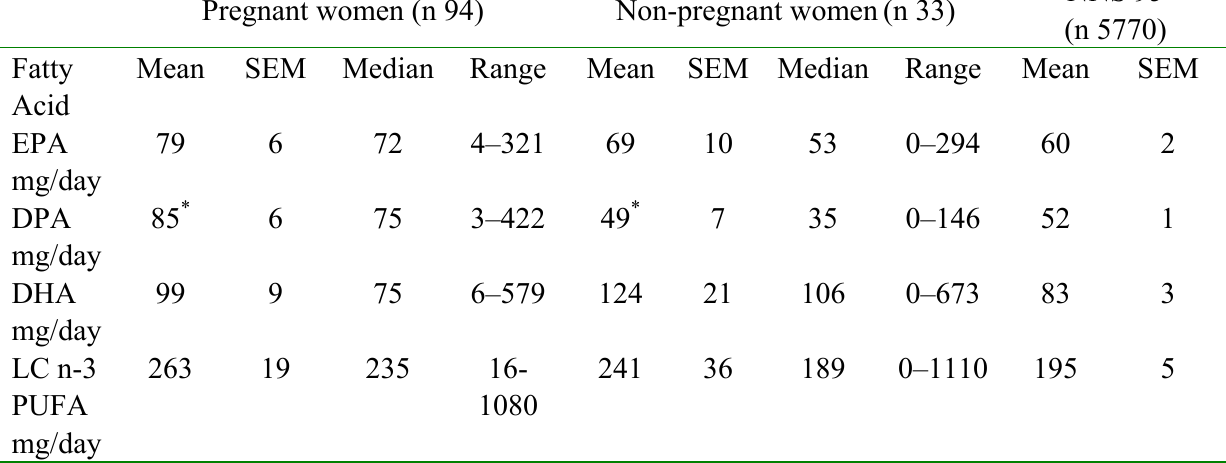
1 Abbreviations: LC n-3 PUFA - Long Chain Omega-3 Polyunsaturated Fatty Acid; NNS 95